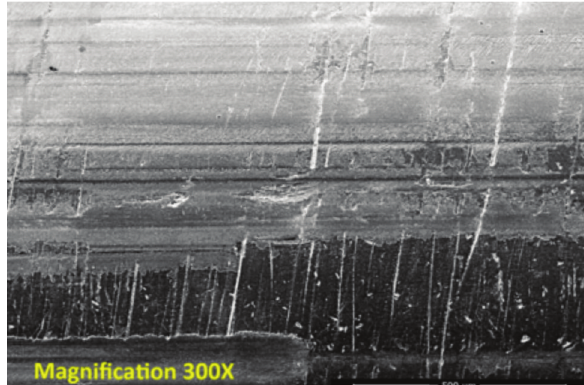
SEM image from inferior ridge of the FNE from Patient 2 Fig. 7: with medial migration showing both transverse and longitudinal scratch marks (magnification 300x).